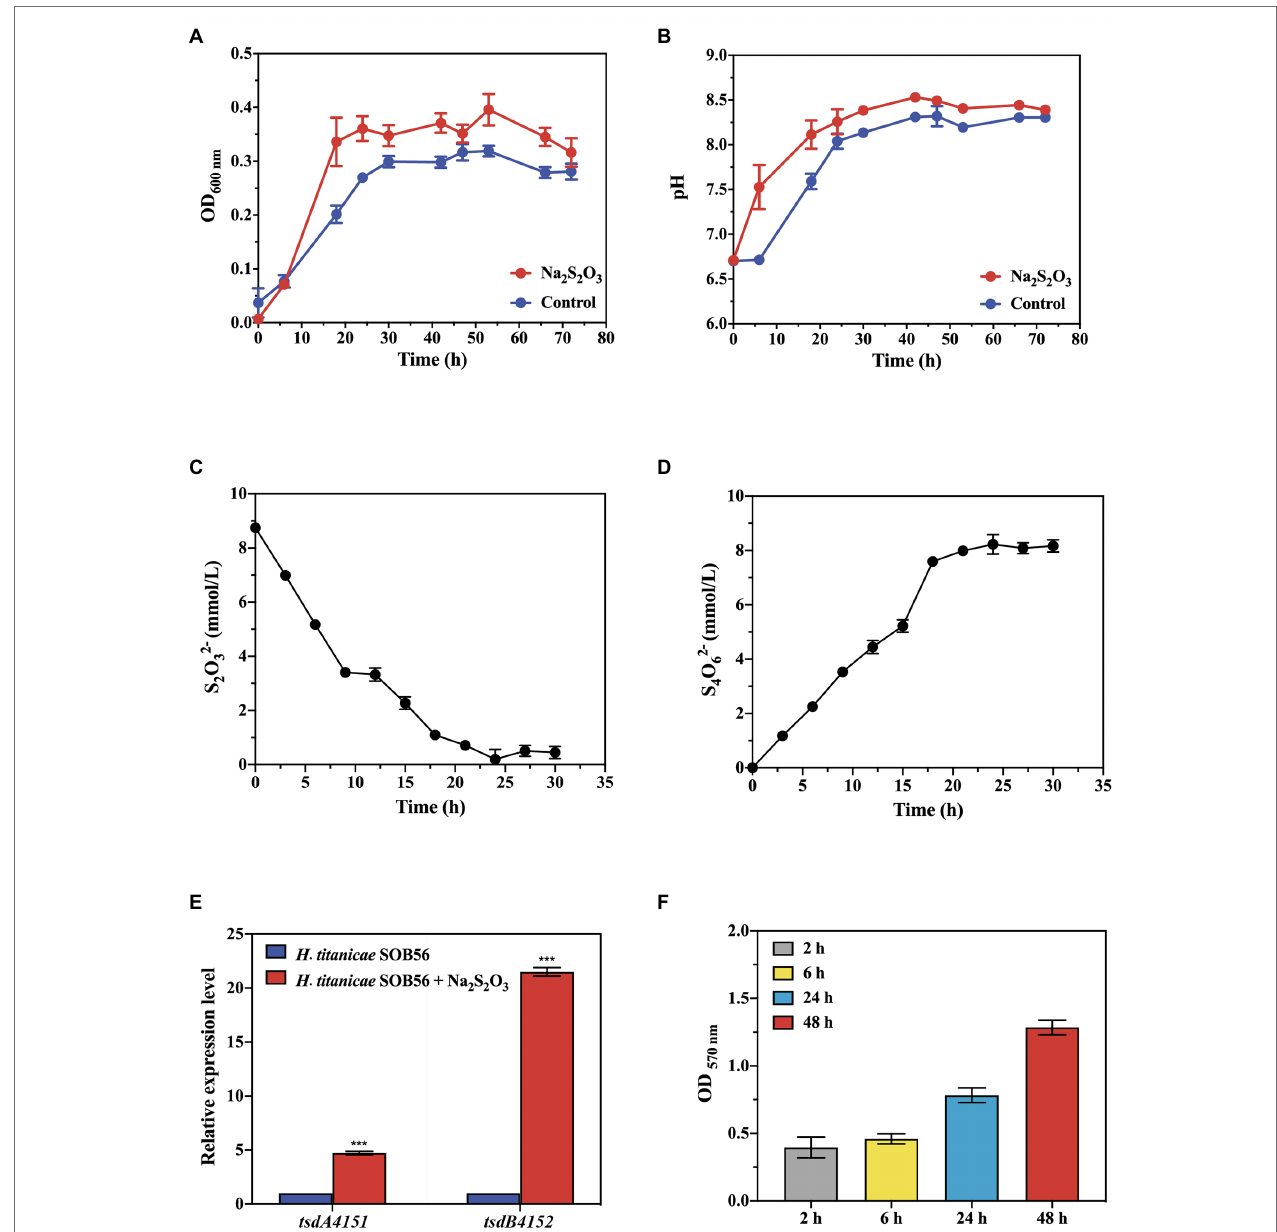
FIGURE 2 | The growth of train SOB56 and its Na 2 S 2 O 3 oxidizing ability. (A) The change of OD 600 nm . (B) The change of pH. (C) The change of S 2 O 32 − concentration. (D) The change of S 4 O 62 − concentration. (E) Expression of genes tsdA4151 and tsdB4152 in Halomonas titanicae SOB56. Three biological replicates and three technical replicates were used for each gene/condition. The error bars represent the standard deviations for three replicates. For statistical analysis, significance was analyzed with a t -test of unpaired unequal variance, *** p < 0.01. The error bars represent the standard deviations for three replicates. (F) Biofilm formation of H. titanicae